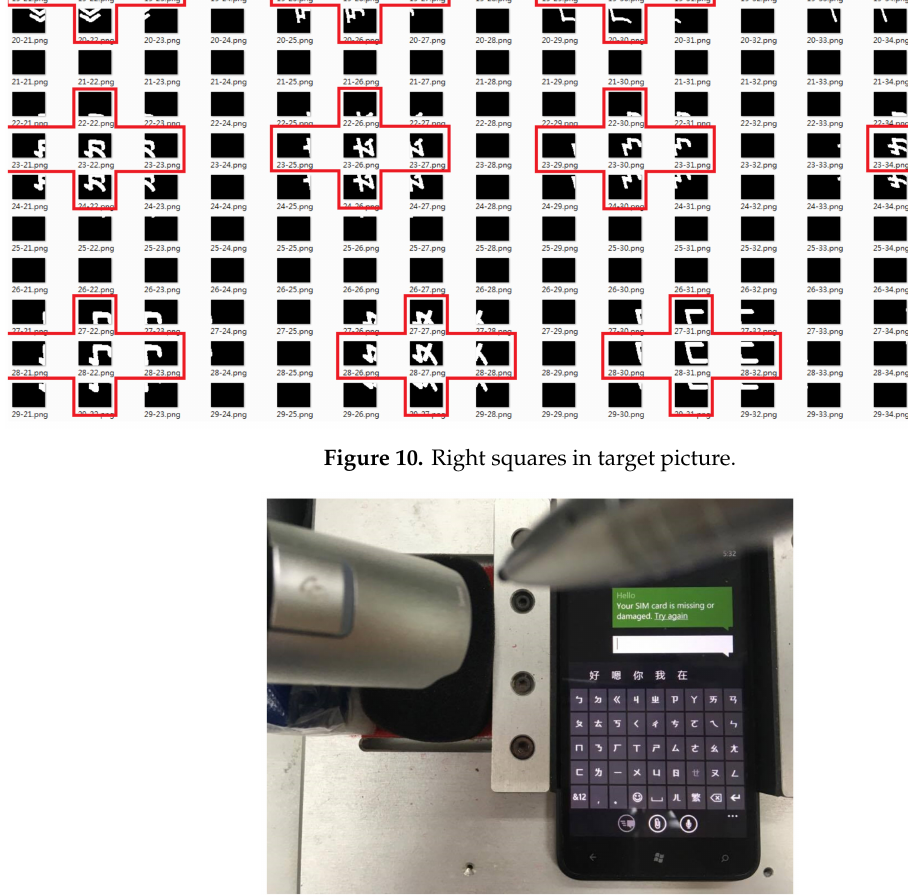
Figure 11. The Mandarin phonetic symbols and Chinese characters image for